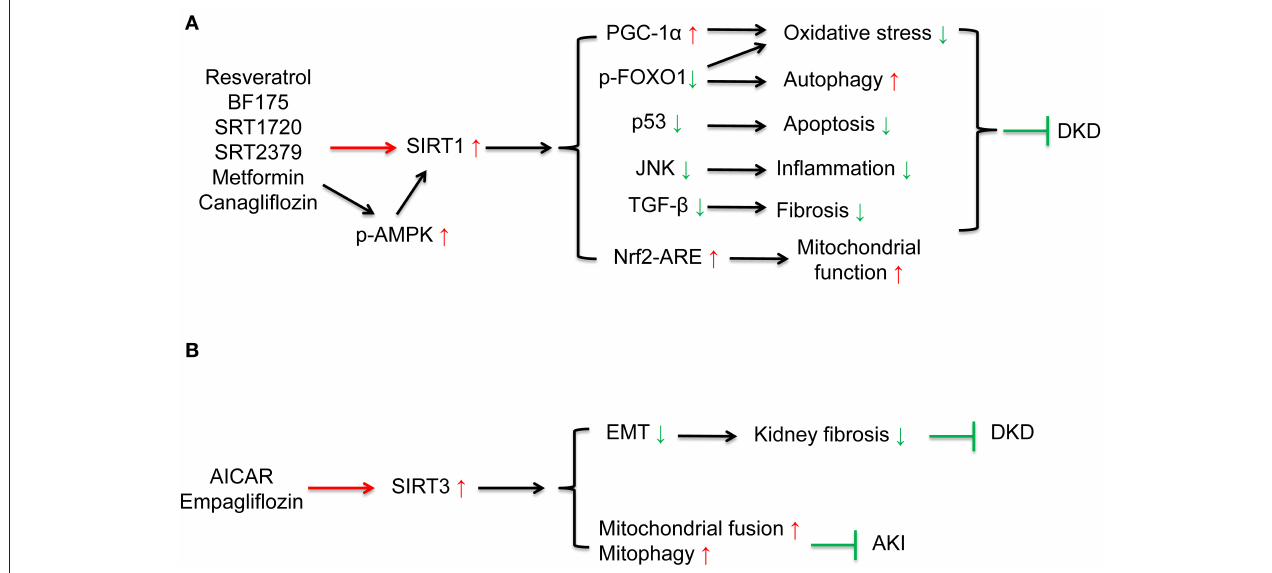
FIGURE 4 | Drug interventions on sirtuins activation in the treatment of kidney diseases. (A) SIRT1 activation can ameliorate oxidative stress, apoptosis, fibrosis, inflammation, restore autophagy, and mitochondrial function. SIRT1 agonists, resveratrol, BF175, SRT1720, SRT2379, and some anti-diabetic drugs including metformin and canagliflozin can activate SIRT1 to protect against DKD. (B) AICAR can increase mitochondrial fusion and mitophagy via activating SIRT3 to protect against DKD. SGLT2 inhibitor empagliflozin can ameliorate kidney fibrosis via restoring high glucose-suppressed SIRT3 to protect against DKD.